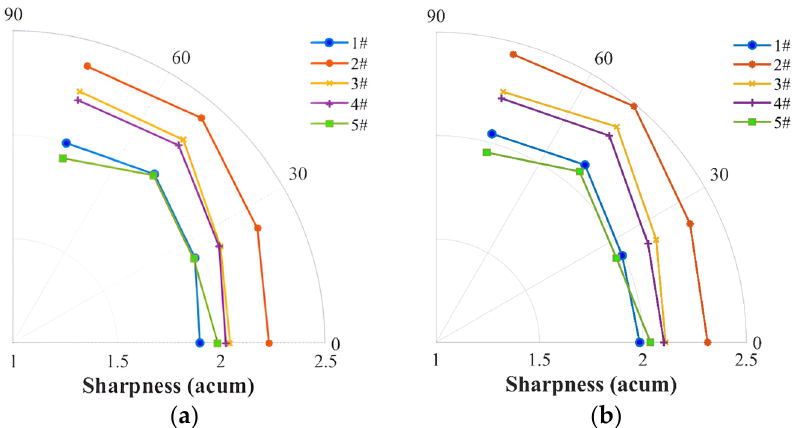
Figure 14. Comparison of noise sharpness among the two-blade propeller (#1), four-blade propeller (#2), loop-type propeller (#3), wide chord loop-type propeller (#4), and DJI Phantom III propeller (#5) at a rotational speed of 5400 rpm ( a ) and at a stable thrust of 3 N ( b ).